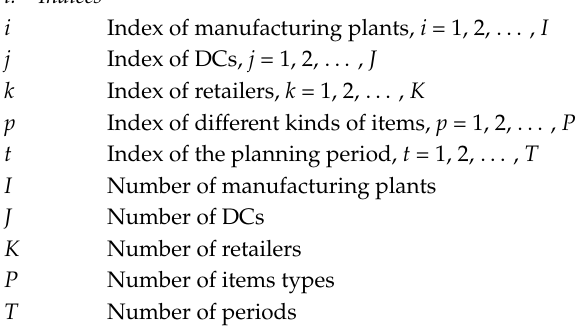
Figure 4. The considered supply chain network.